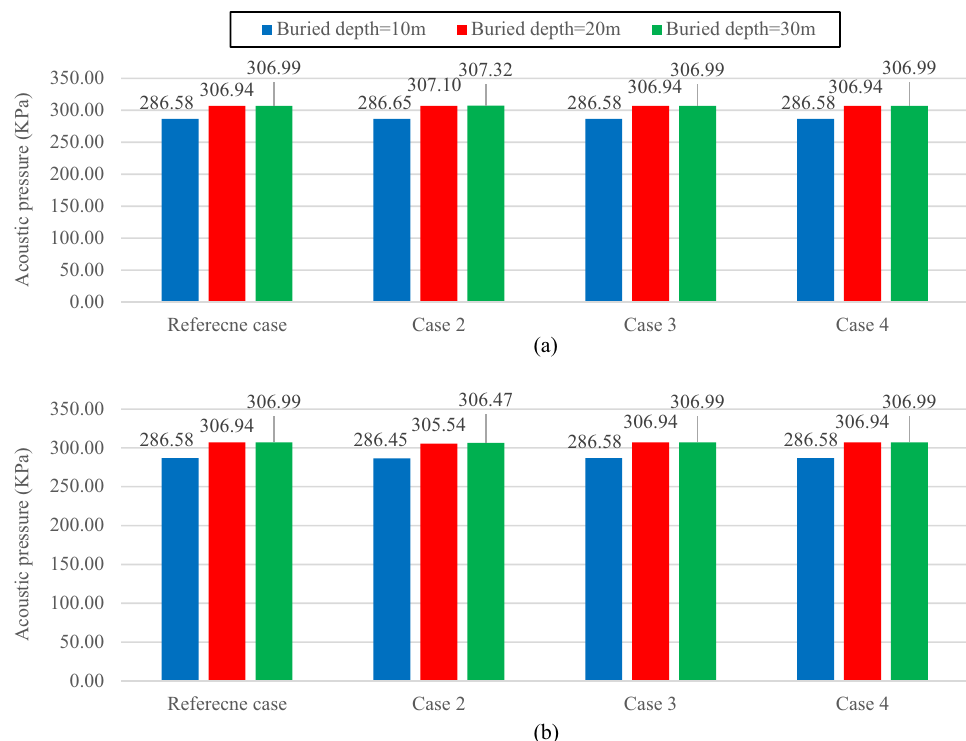
Figure 4. Maximum reflected acoustic wave pressure for the reference case model alongside the ( a ) stiffer and ( b ) softer soil